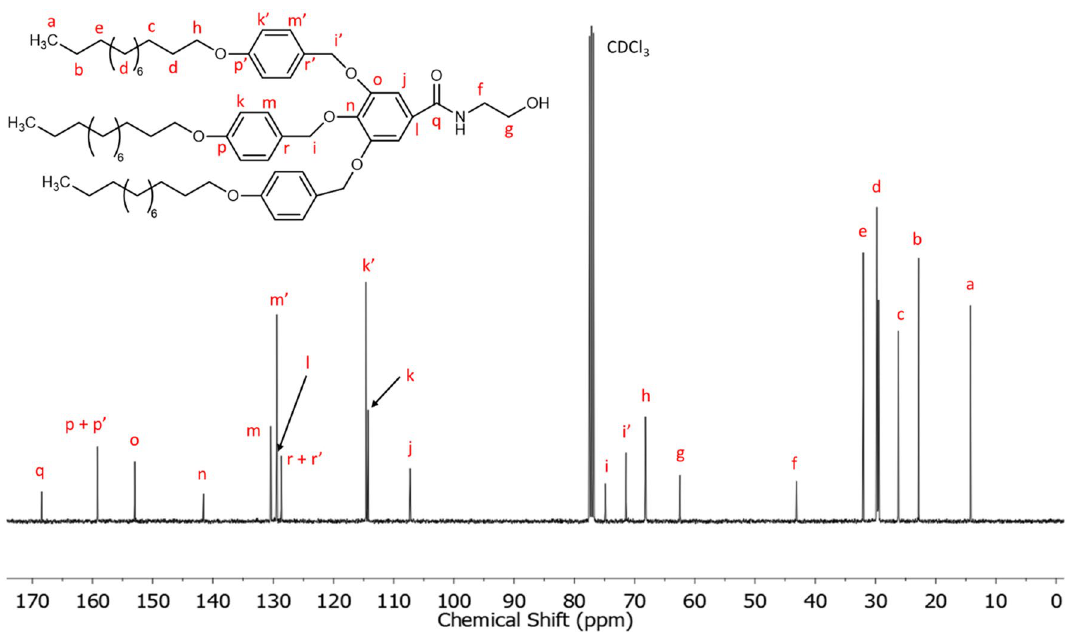
Figure 4. 13 C NMR spectrum in CDCl 3 of